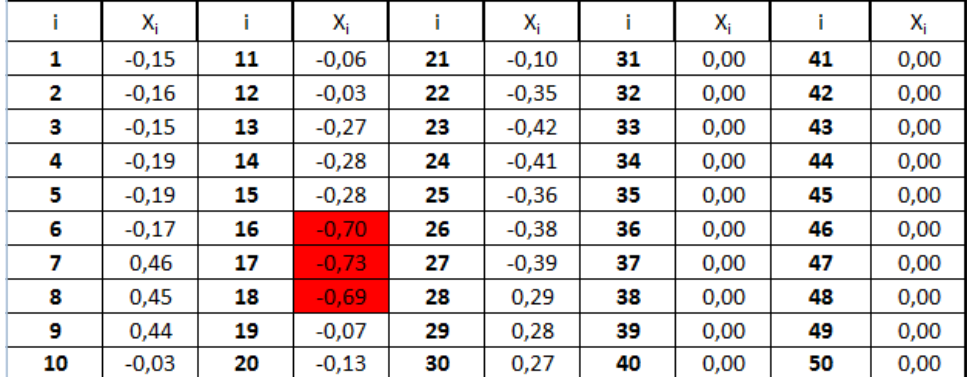
Figure 3: Imported data